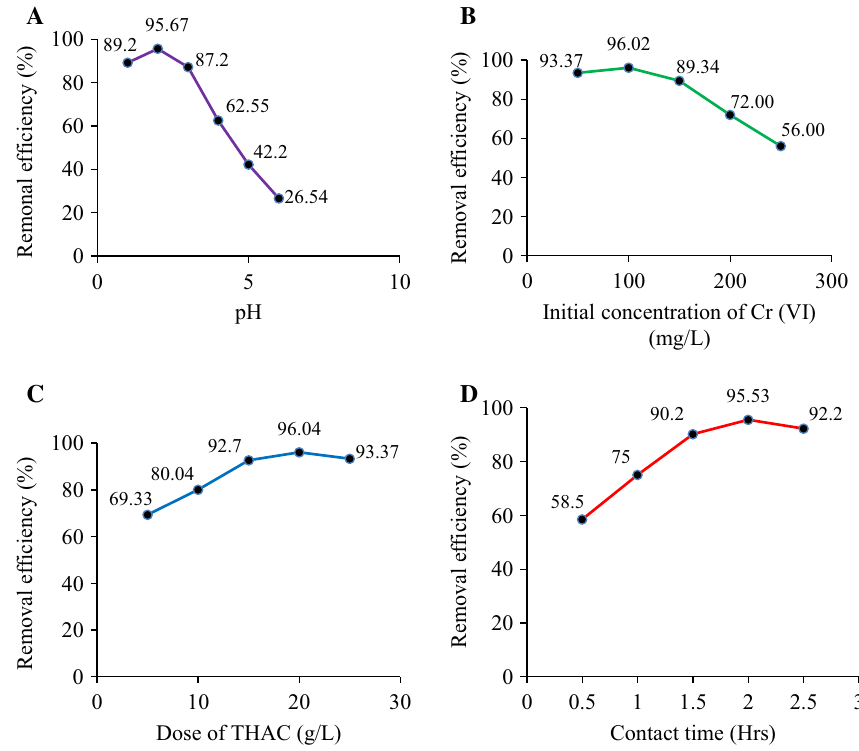
Fig. 2 Effect of a pH, b initial conc. of Cr(VI), c dose of THAC, d contact time on the Cr(VI) removal efficiency of THAC: adsorption condition: volume of solution 100 mL, pH 2, Cr(VI) conc. 100 mg/L, amount of THAC 2.0 g, contact time 2 h, and temperature 25